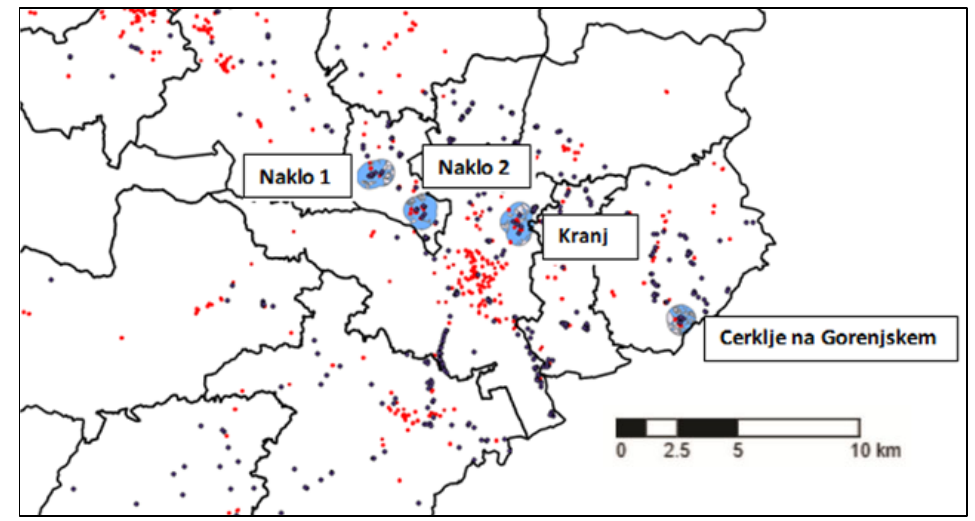
Figure 7. Selected final locations (Red dots-waste and oils, Black dots-Farms with number of LU). Although areas with a relatively high density of waste and LU (red and black points) are visible on the map, they do not represent a large enough potential for setting up